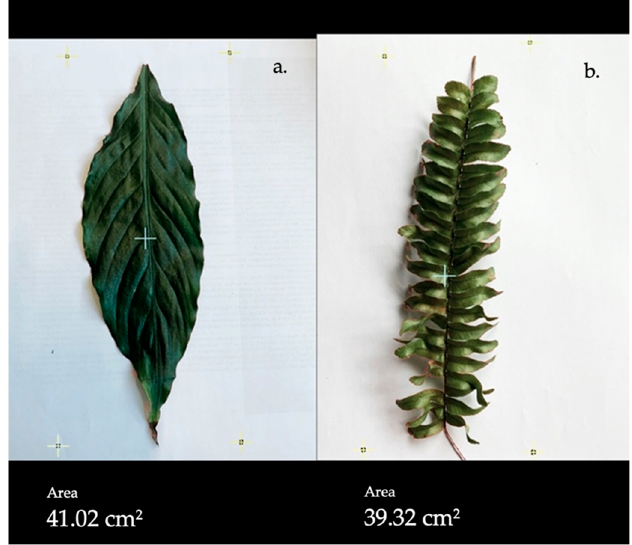
Figure 3. Scan and calculation of the leaf area: ( a ) peace lily; ( b ) Boston fern.